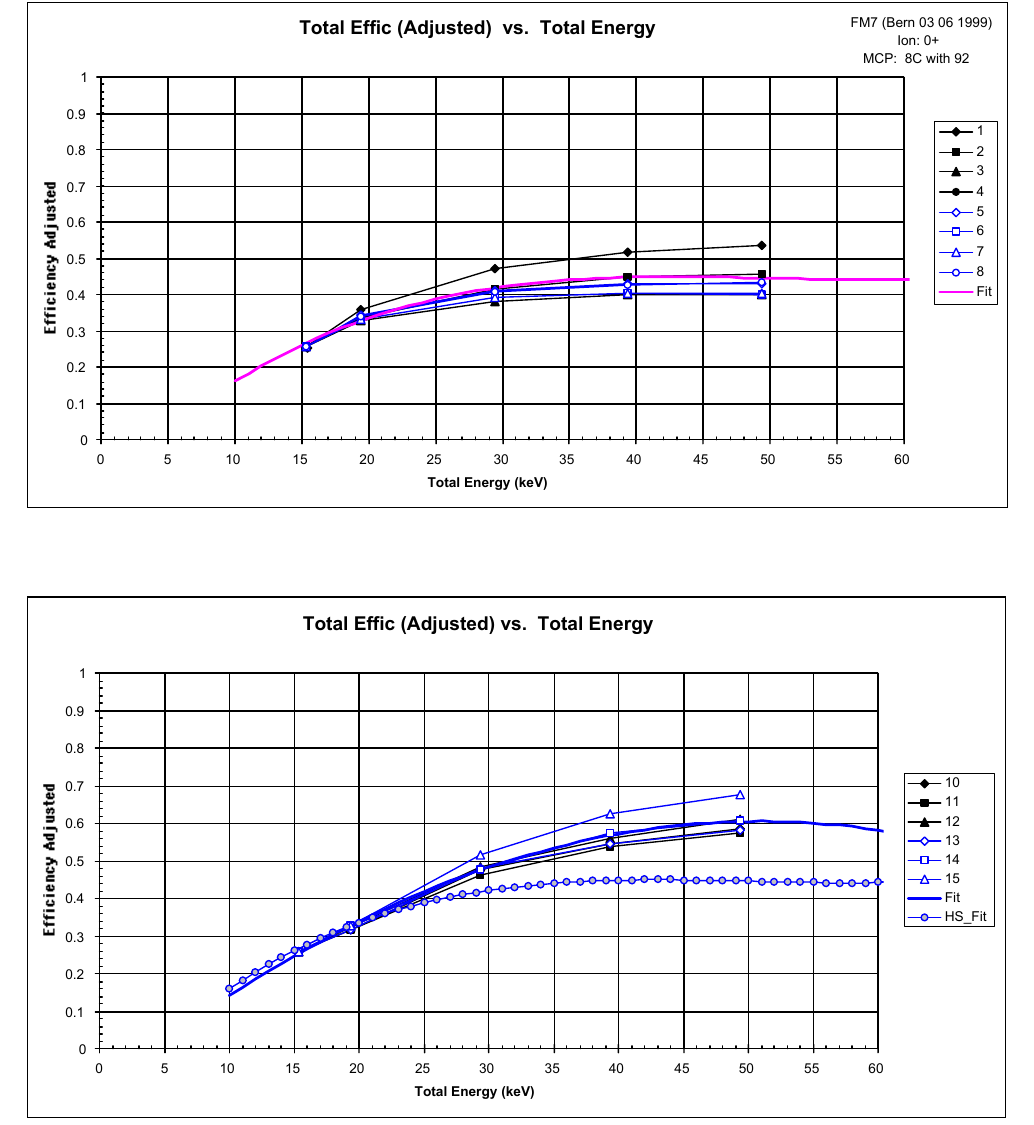
Fig. 15. CODIF FM7 High Side normalized total efficiency verses total energy for O + for the different anodes and with a general fit (upper curve) and CODIF FM7 Low Side normalised total efficiency verses total energy for O + for the different anodes and with a general fit; High Side fit of the upper curve is added (lower